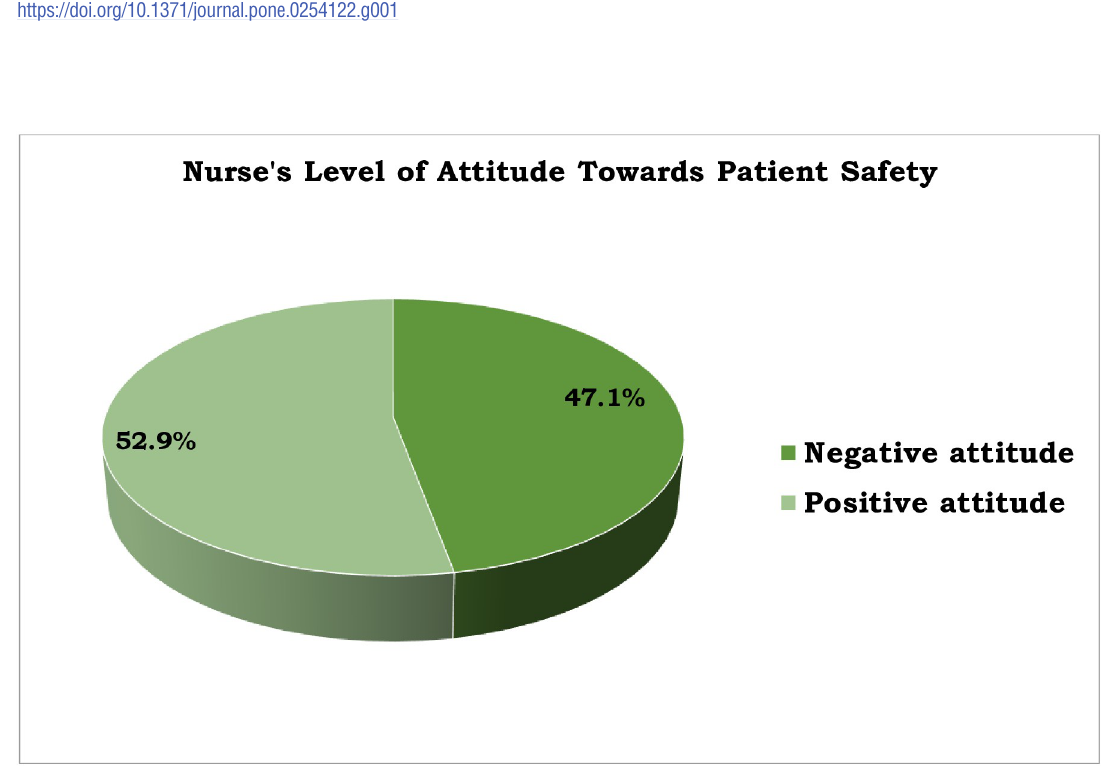
Fig 2. Nurse’s level of attitude about patient safety among nurses working at Asella Referral and Teaching Hospital, Asella, Ethiopia, 2021, [n = 172].